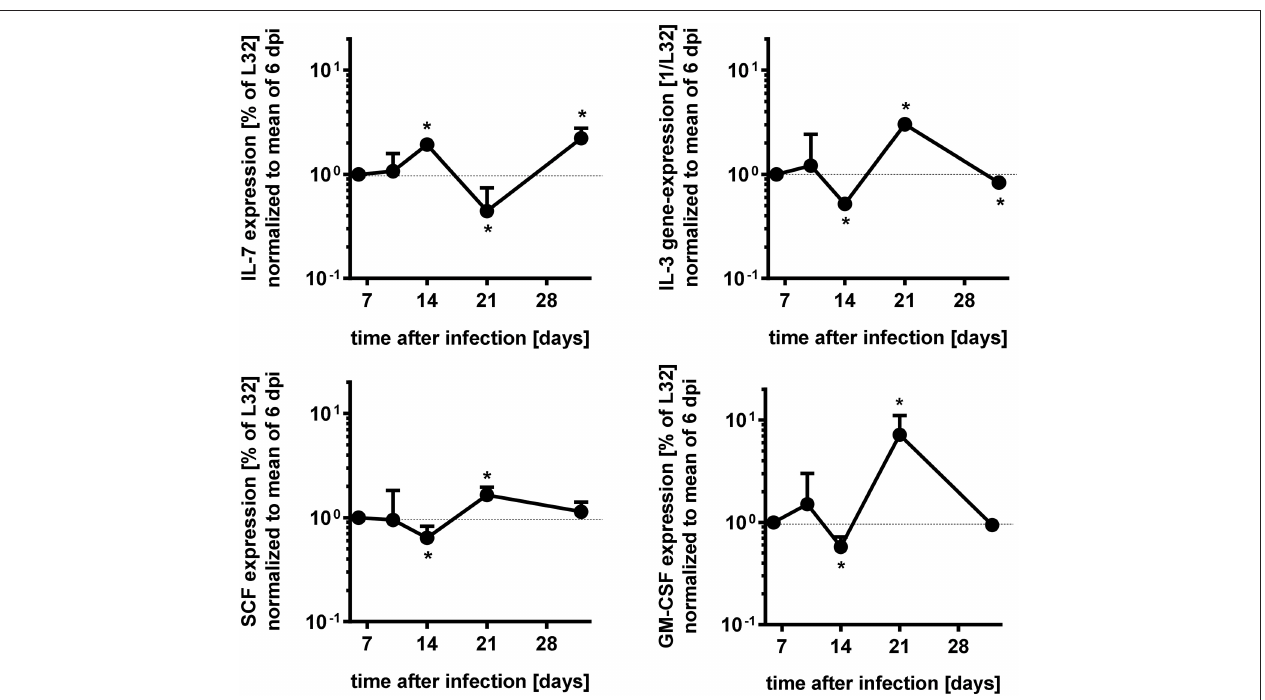
FIGURE 6 | Modulation of gene expresssions during acute T. cruzi expression of bone marrow cells. Gene expression of Il7 , Il3 , Gm-csf , and Scf i n the bone marrow of infected mice were measured by RNase protection assay to time course dependent expressions. The values were first normalized to the expression of gene L32 and second to the mean of the data of 6 dpi. Data represent mean ± SD of pooled results from two independent experiments each comprising 3 mice per time point, infected with 500 T. cruzi blood trypomastigotes i.p.. Shown are the mean values and the upper error bars. Statistical analysis was performed using Wilcoxon rank sum test for significant differences. * p >